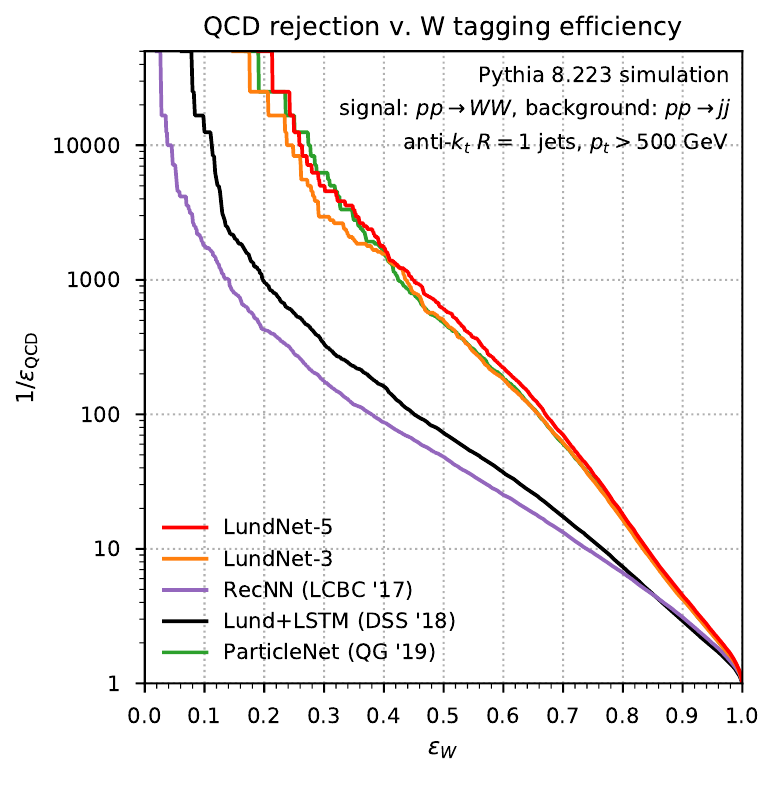
Figure 4 . Background rejection 1 /(cid:15) QCD versus signal efficiency (cid:15) W for W jet tagging with trans- verse momentum p 500 t >